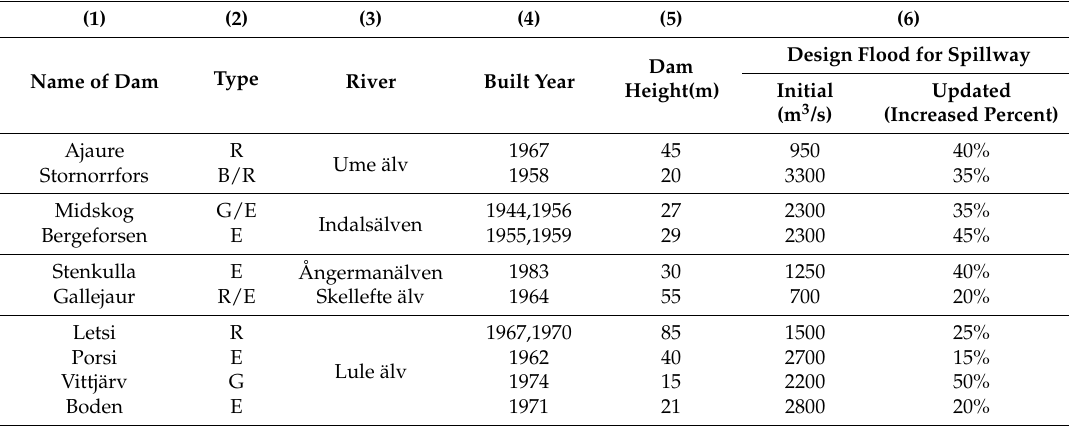
Table 12. The higher design flood water level in the new flood guideline.